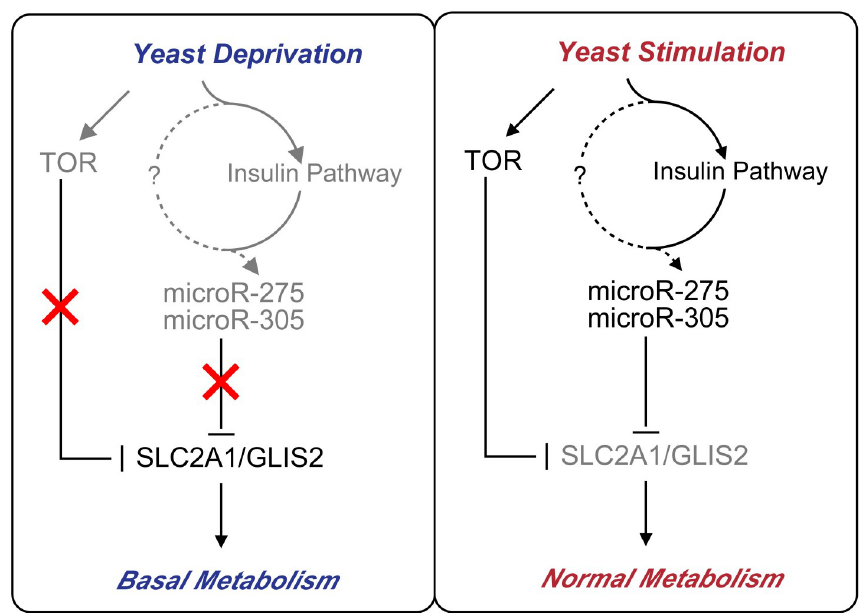
Fig 9. Schematic diagram of miR-275/305 cluster role in modulating dietary yeast-dependent metabolic homeostasis. Our proposed model summarizes the mechanism by which miR-275/305 targets SLC2A1/GLIS2 to regulate energy metabolic homeostasis. In the presence of dietary yeast, the activation of the insulin signaling pathway is followed by the activation of the miR-275/305 cluster expression, which in turn inhibits SLC2A1/GLIS2 transcription via binding their 3’UTR region. Meanwhile, TOR can directly act on target genes without affecting miRNAs. This cascade regulation finally ensures normal metabolic physiology. Dietary yeast may contribute to the activation of the miR-275/305 cluster through an unknown pathway (indicated by dashed lines and question marks). Under yeast deprivation conditions, either the activity of insulin or the TOR signaling pathway was low, and the expression of SLC2A1/GLIS2 was derepressed, thus ensuring the basal metabolism needed. Arrows and T-shaped symbols represent activation and inhibition, respectively. Dashed arrows denote the unknown pathway, the components that are less active or inactive are shown in grey, while red crosses indicate shut-down